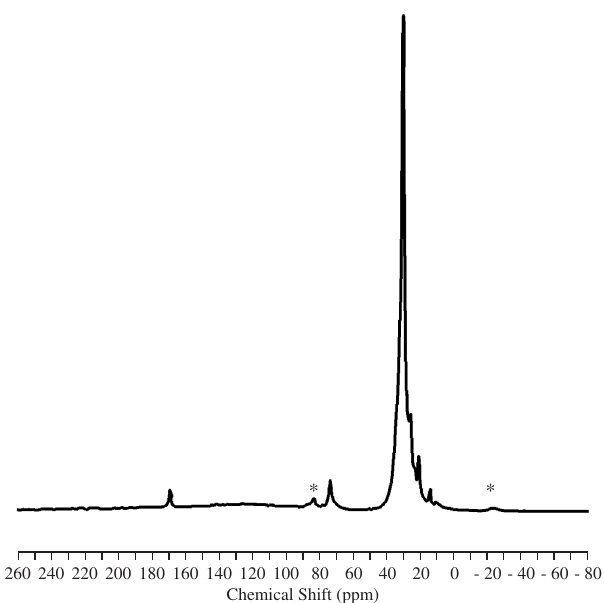
Figure 4. 13 C MAS spectrum of recycled